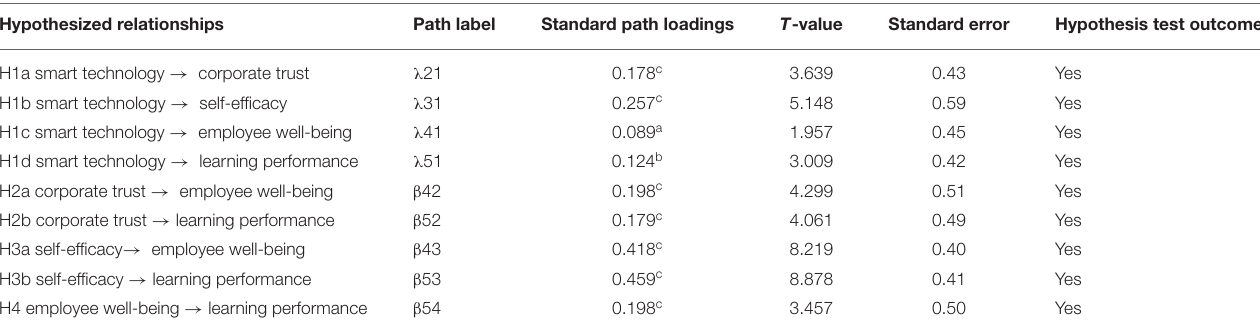
TABLE 2 | Measurement outcomes. Hypothesized relationships Path